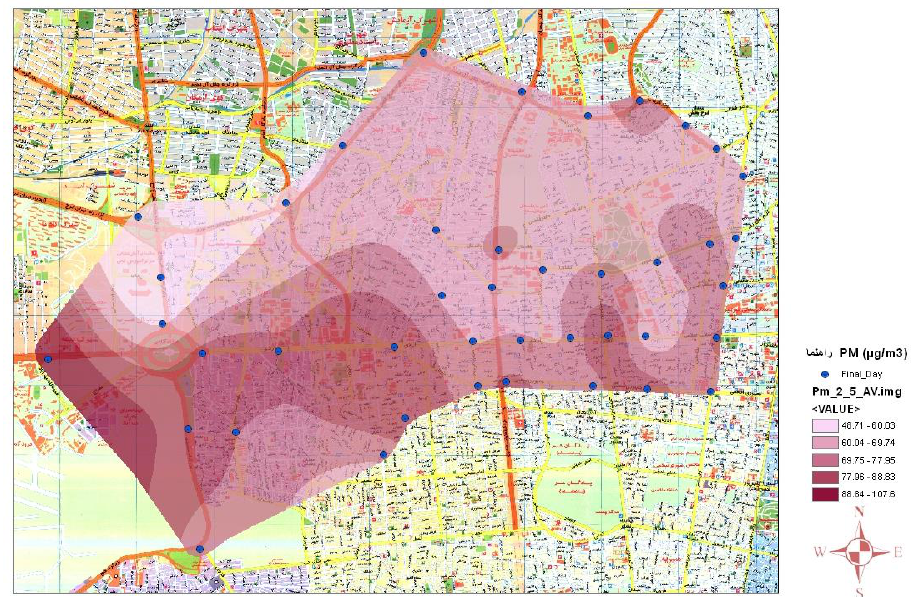
Figure 8. The distribution of mean concentration of PM 2.5 in the selected region (cold